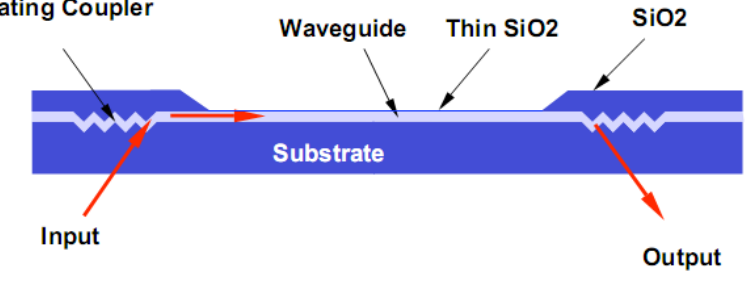
Figure 2. Grating coupler for efficient